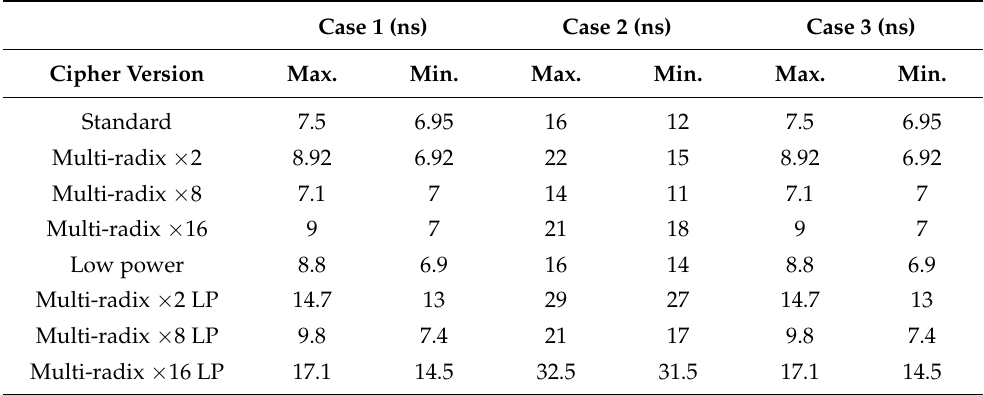
Table 3. Short-pulse range values obtained for each cipher in different scenarios. Case 1—nominal power supply. Case 2—minimum power supply. Case 3—nominal circuit